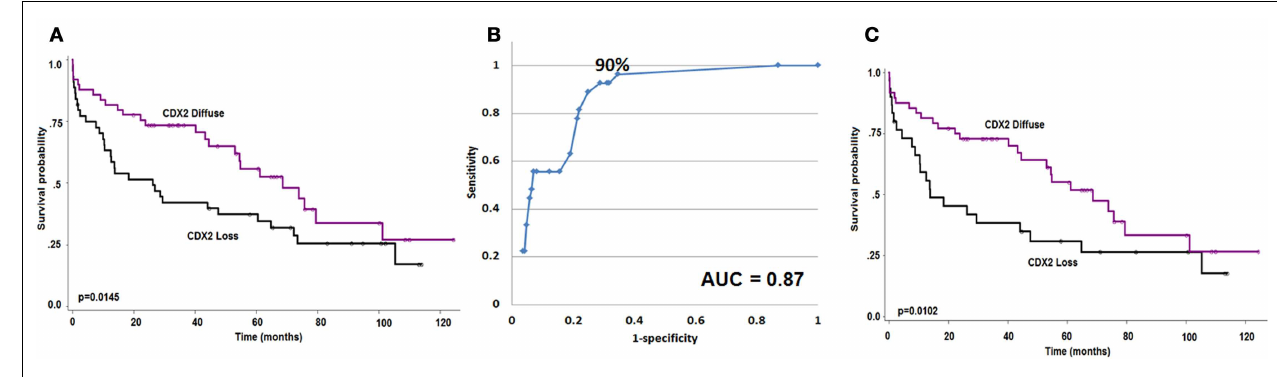
MMR-deficiency. (C) Kaplan–Meier survival curve showing effect of Cdx2 expression on overall survival in MMR-proficient colorectal cancer patients only ( n = 78).Wilcoxon’s test.